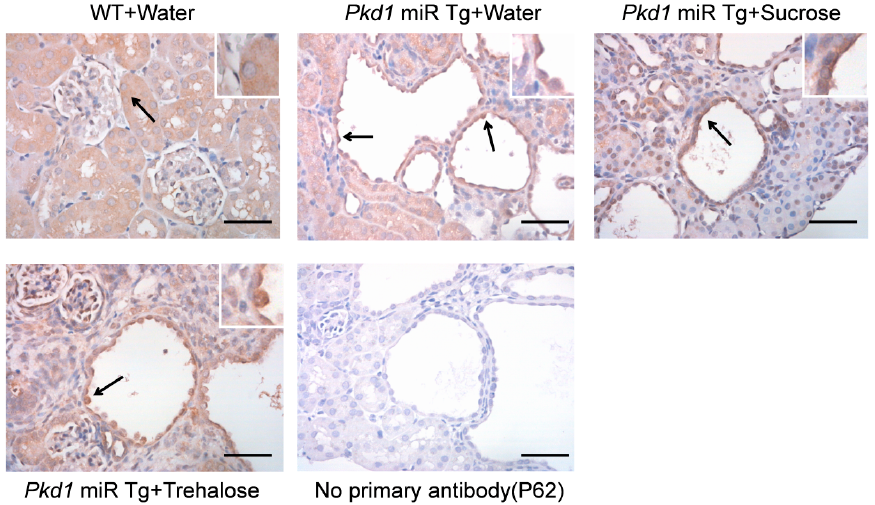
Figure 7. Increased expression of p62 protein in cyst-lining epithelial cells in Pkd1 miRNA transgenic mice. Both wild-type and Pkd1 miR Tg mice exhibited weak cytoplasmic p62 staining in noncystic tubular epithelial cells. Strong p62 staining (arrows) of the cystic epithelial cells in Pkd1 miR Tg mice was present, indicating reduced autophagic degradation of the p62 protein. No significant differences in p62 staining were found among the different treatment groups. The negative control sections, without primary antibody, showed no staining. The right insets show higher magnification of the areas indicated by arrows. Representative images are shown ( n = 3 per group). Scale bar, 50 µ